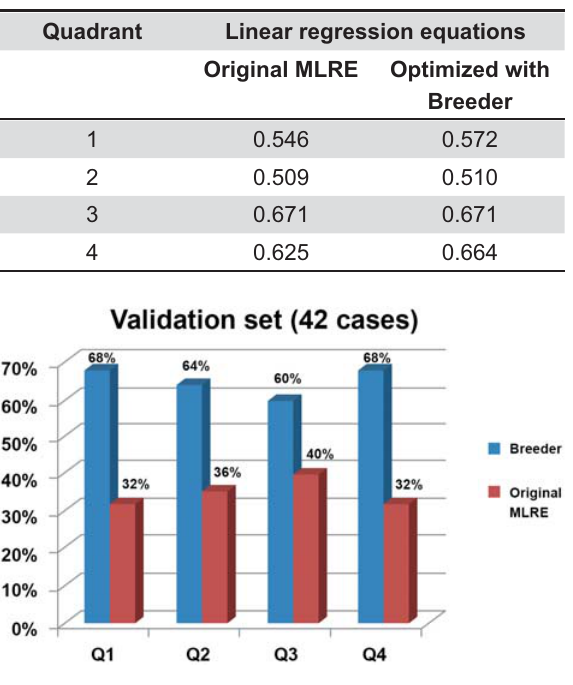
Table 3- (cid:2)(cid:3)(cid:4)(cid:5)(cid:6)(cid:7)(cid:8)(cid:8)(cid:4)(cid:9)(cid:10)(cid:11)(cid:12)(cid:7)(cid:13)(cid:5)(cid:6)(cid:7)(cid:4)(cid:14)(cid:15)(cid:6)(cid:12)(cid:4)(cid:13)(cid:11)(cid:16)(cid:5)(cid:8)(cid:5)(cid:14)(cid:7)(cid:8)(cid:5)(cid:17)(cid:18)(cid:9)(cid:11)(cid:12)(cid:19)(cid:9)(cid:4)(cid:5)(cid:9)(cid:12)(cid:13)(cid:4)(cid:10)(cid:8)(cid:5) regression